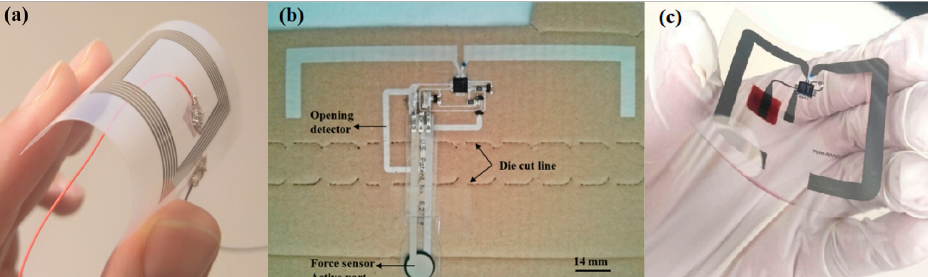
Figure 7. ( a ) A printed RFID coil by the authors; ( b ) a fabricated RFID tag with an opening sensor and force sensor as a part of the packaging [39]; ( c ) an RFID tag with light detection capabilities printed on a flexible PEN substrate [40].